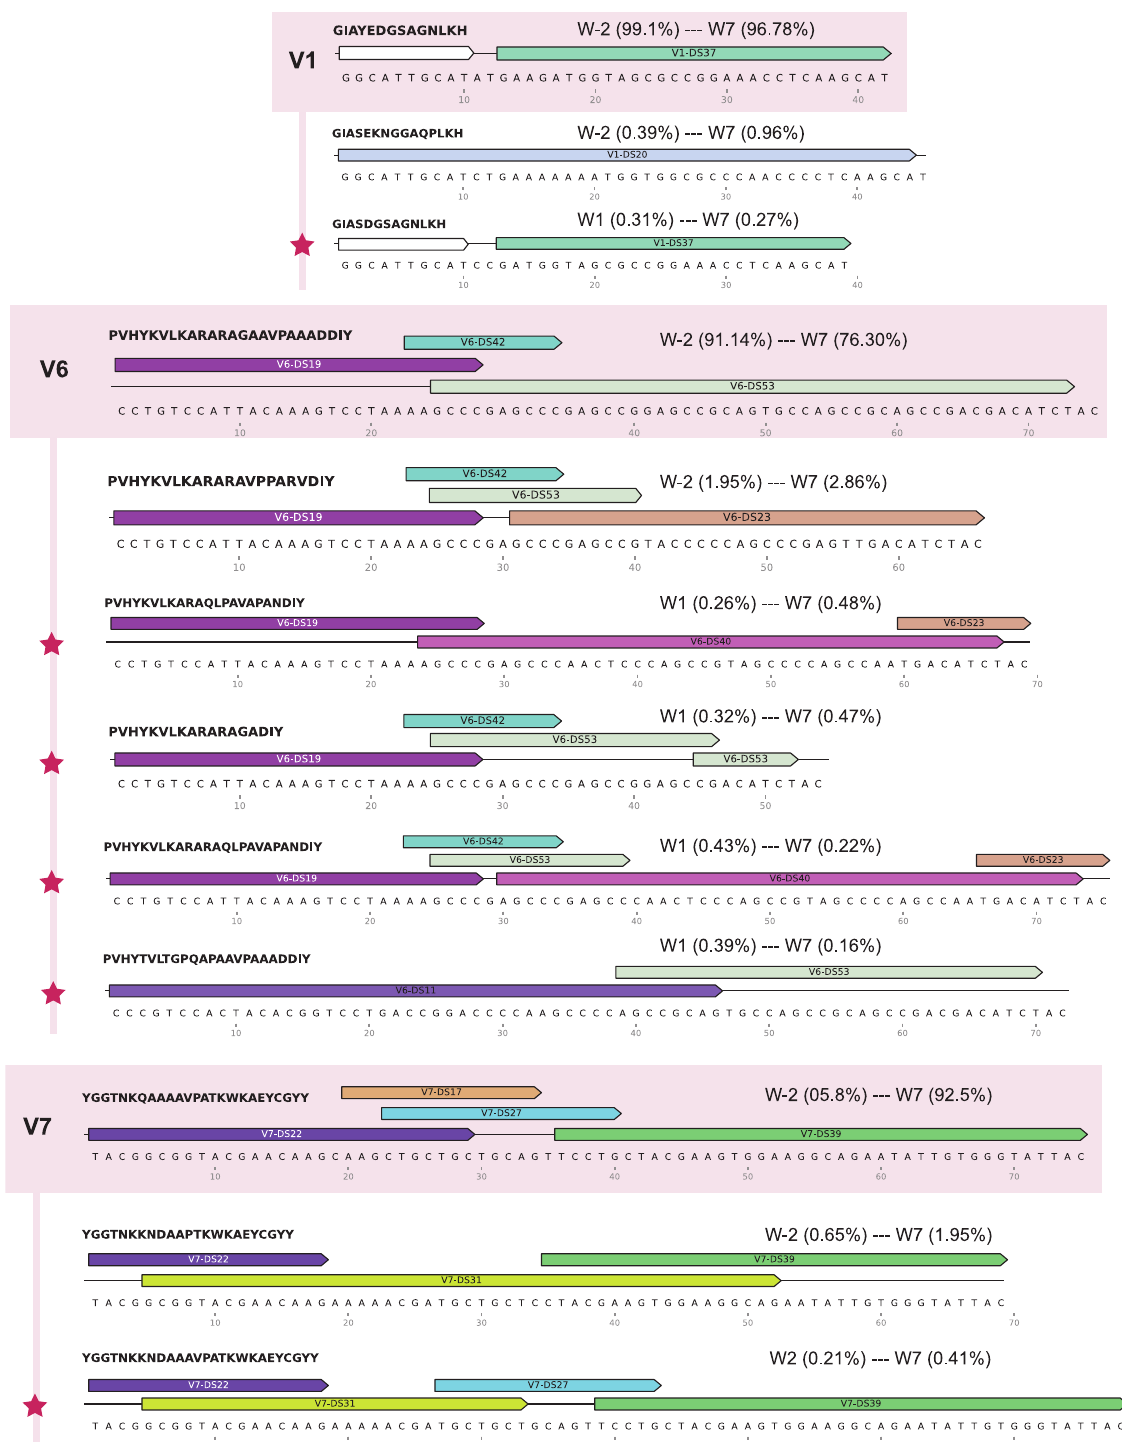
Fig 8. Donor site contributions for novel tprK V region alleles present in any timepoint above 0.4% relative frequency. Selected variable regions with newly arising tprK alleles are depicted, with the clonal sequence at the top and highlighted in salmon, followed by the next highest sequence in relative frequency, and then novel alleles absent from inoculum, demarcated by red stars. Donor site segments are illustrated with color-coded arrows above their respective tprK sequences for each variable region. White donor site segments in V1 are segments that are present in all V1 donor sites. The translated amino acid sequences are at the top left of each allele. Range of relative frequencies of each allele are reported, with week numbers and respective relative frequencies.